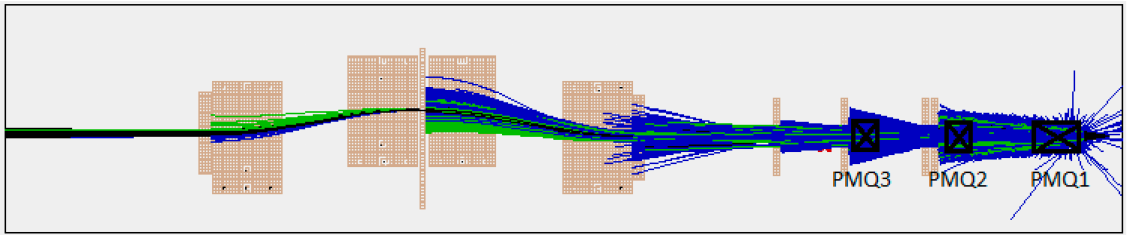
Figure 8. The results of the full beam optics simulation for 5 MeV proton selection (black trajectories). Blue traces represent lower energies and green trajectories represent higher energies. A proton beam is transported from the right to left